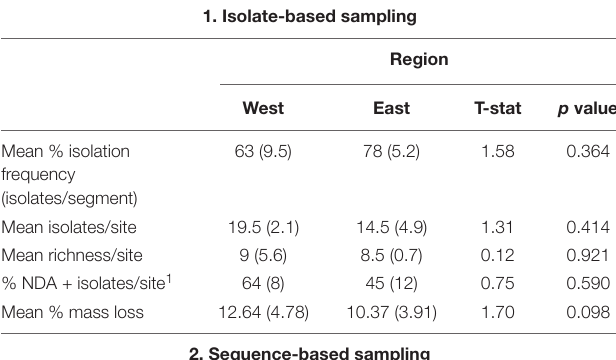
TABLE 2 | Comparison of the endophyte communities in living tillers in the eastern and western regions of the Namib Sand Sea. Mean abundance, richness